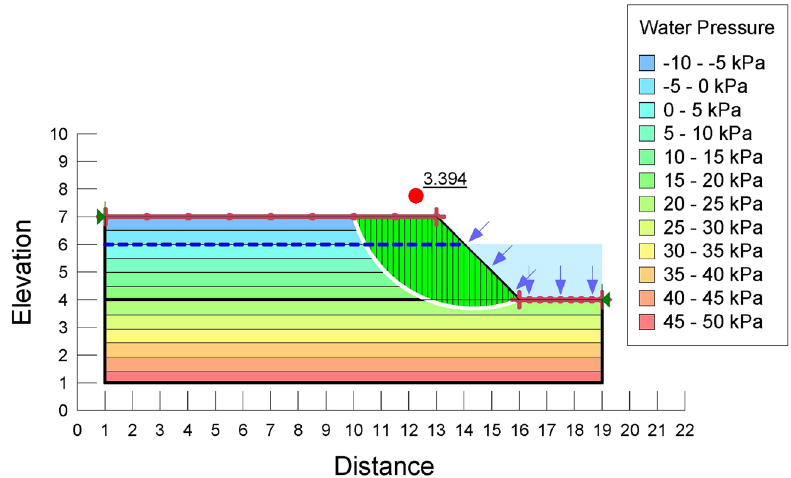
Figure 7: Slope stability before applying rationing system.